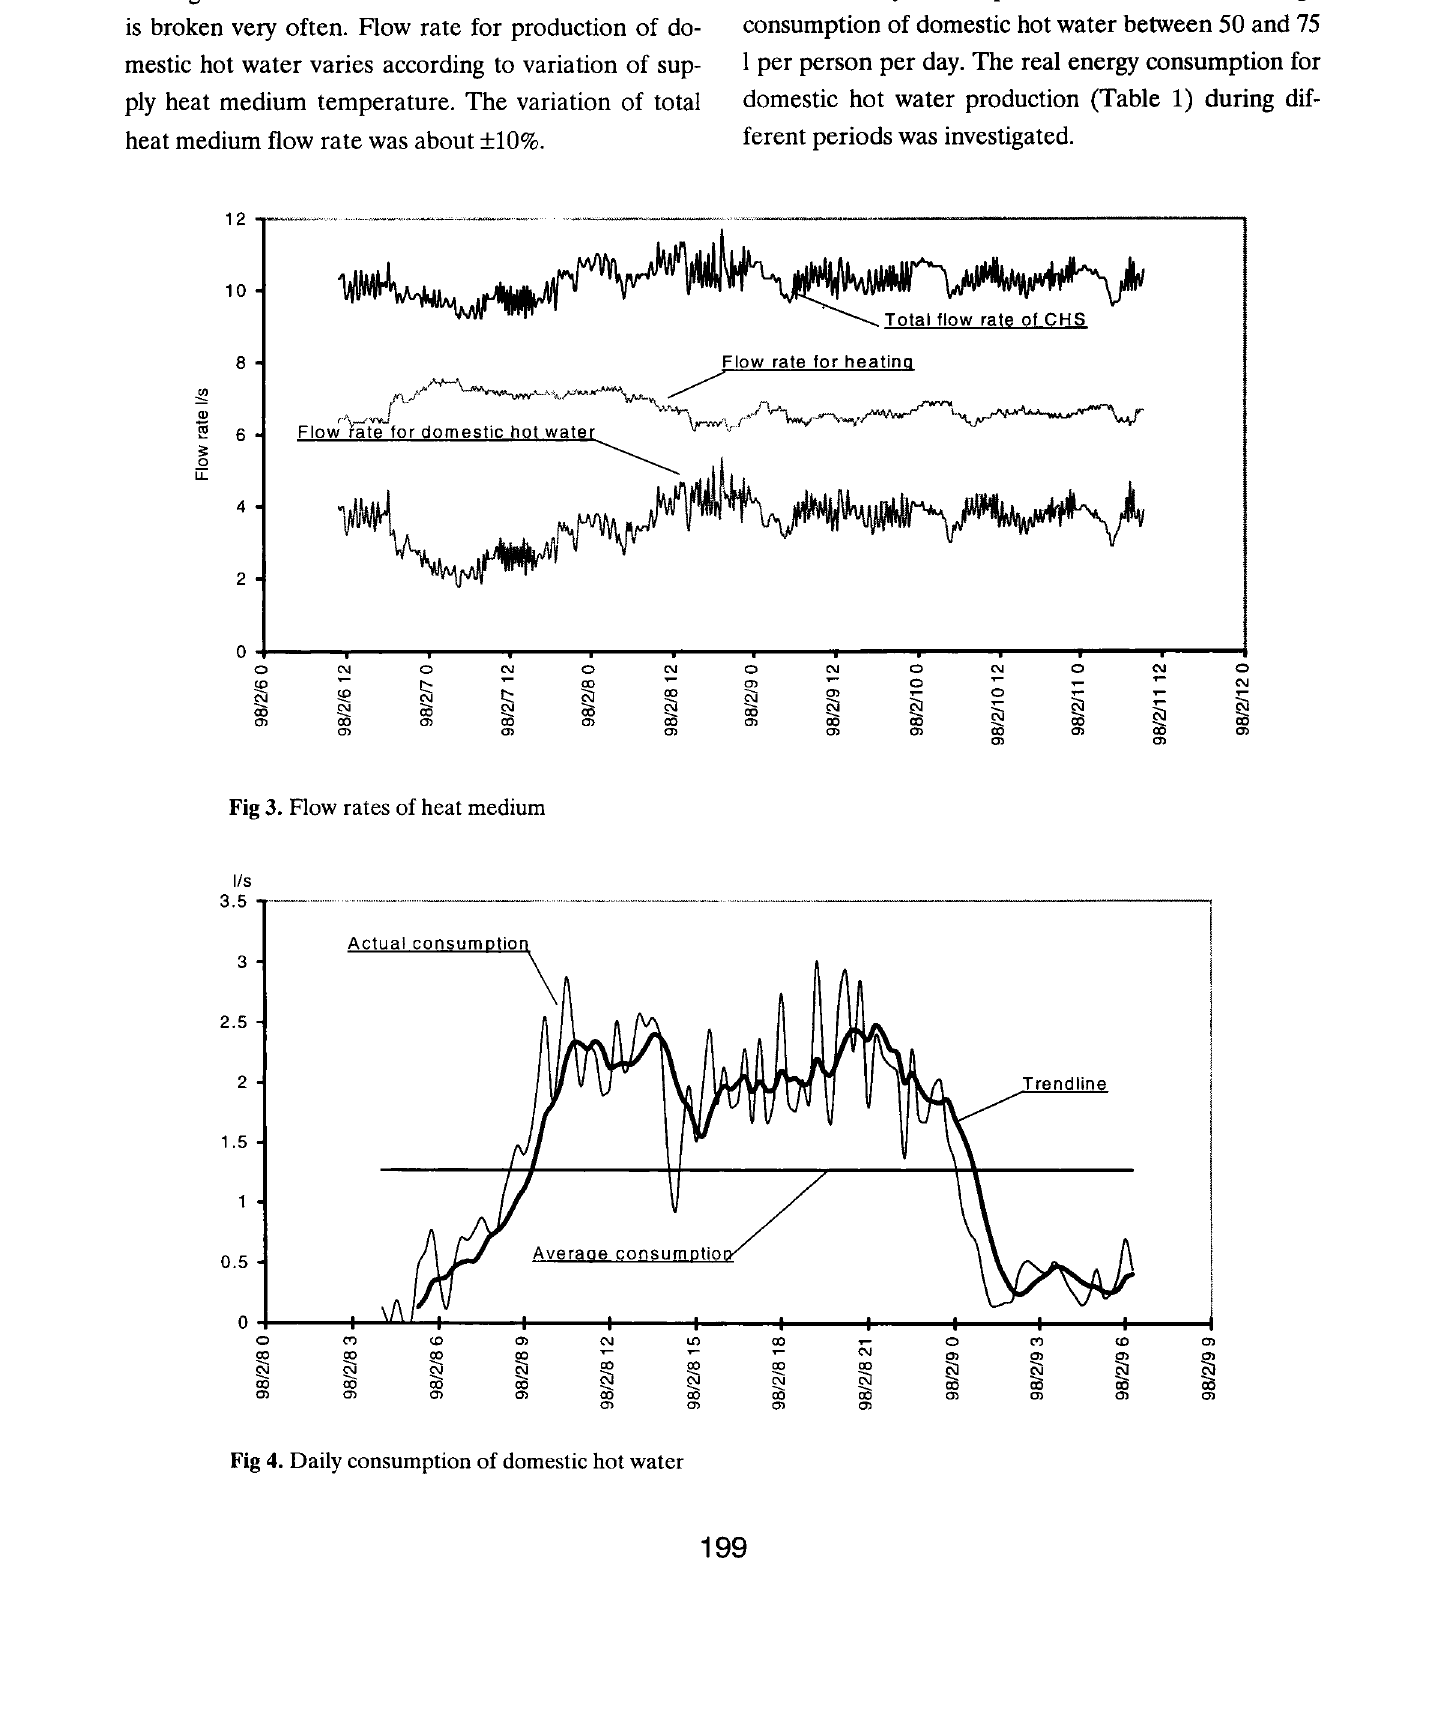
Fig 3. Flow rates of heat medium